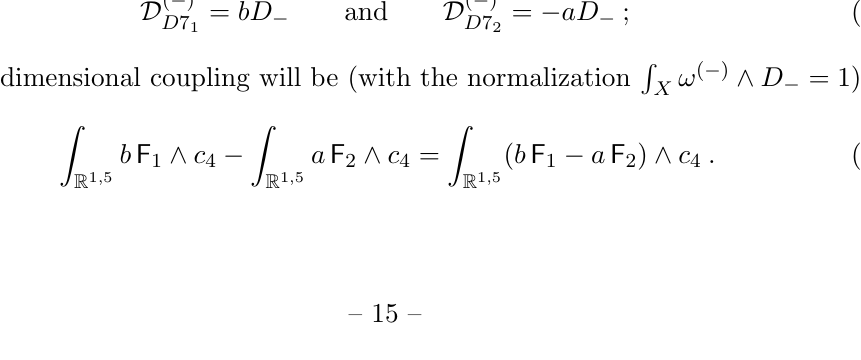
Figure 2 . (i) When branes and image branes intersect away from the orientifold it is possible to get up to charge 4 (with a = 2, b = 1) or up to charge 6 (with a = 3, b = 2). (ii) If D 7 1 and D 7 0 intersect only on top of the O 7, one can only get up to charge 3 (with a = 2, b = 1) or up to charge 5 (with a = 3, b =